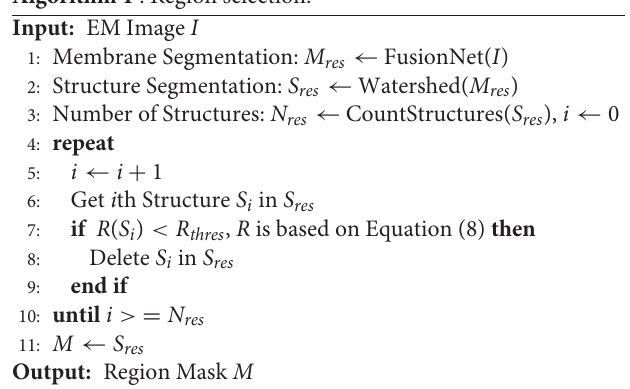
Algorithm 1 : Region